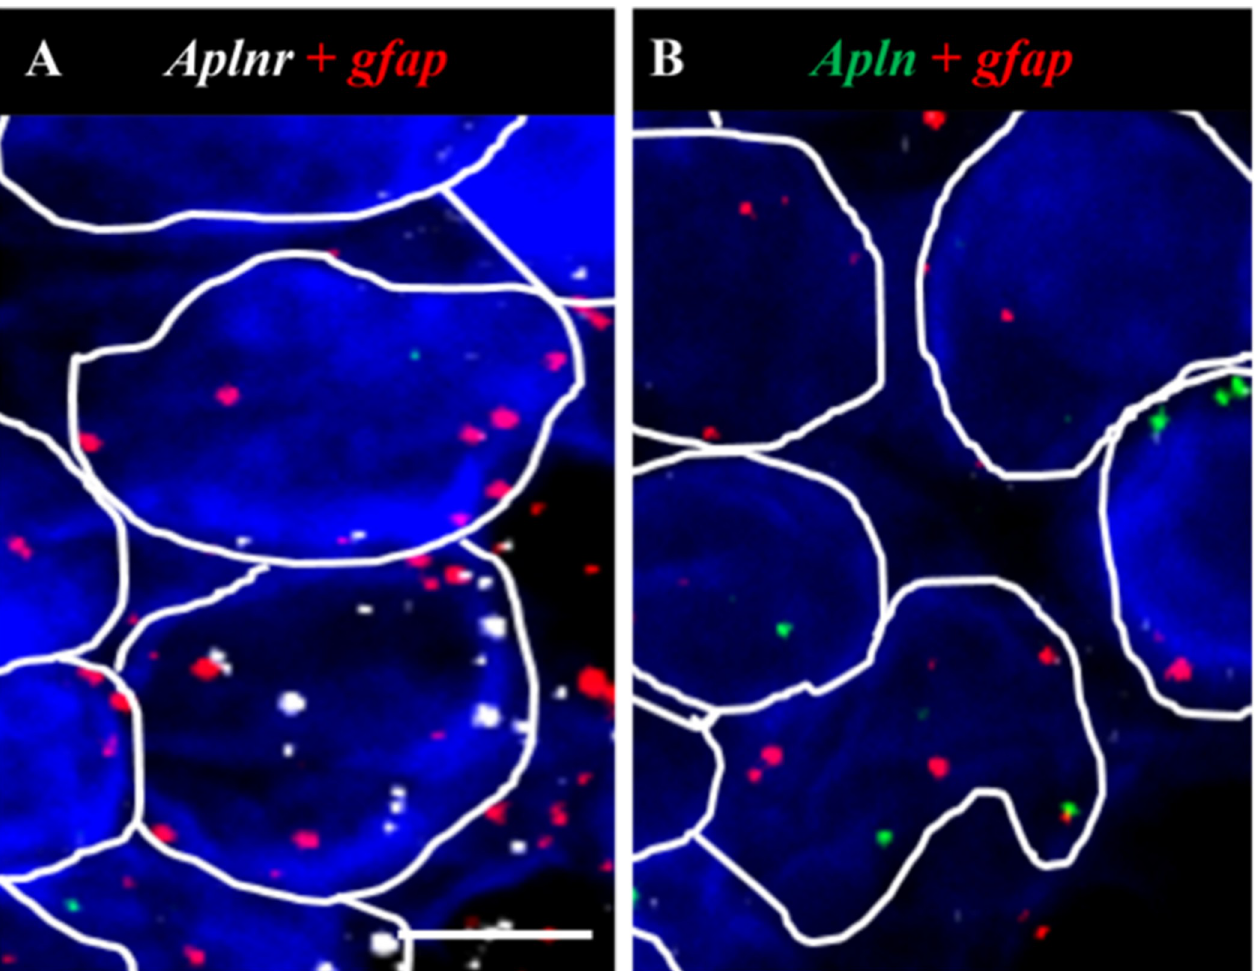
Fig 6. Aplnr and apln transcripts colocalise with gfap in the AP. (A, B) Representative fluorescent images showing colocalization of aplnr (white dots, A) and apln (green dots, B) with gfap (red) in the AP. Scale bar = 20 μ m. n = 4.